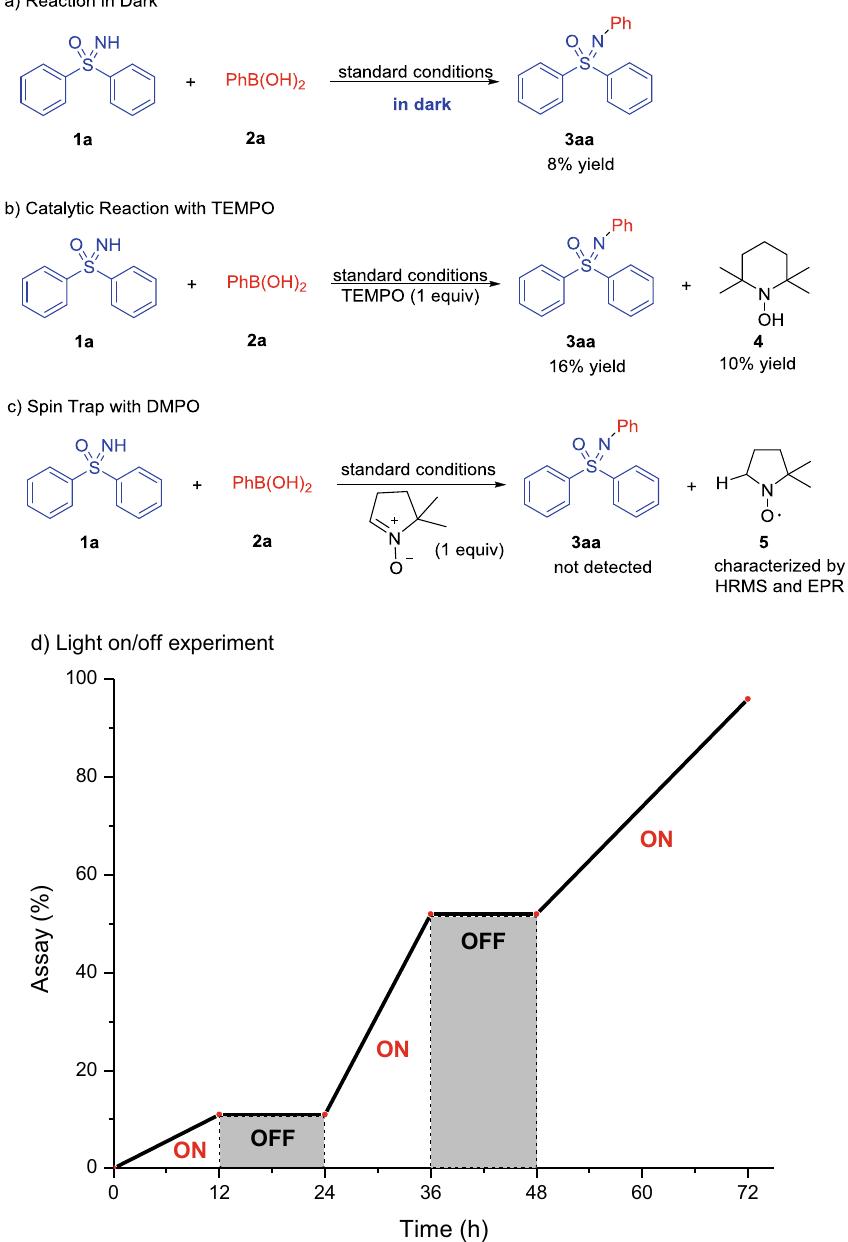
Fig. 2 Mechanistic probes. a Examination of the role of ambient light. b Probing the radical pathway of copper-catalyzed Chan-Lam coupling. c Spin trapping experiments. d Light on/off experiment with copper-catalyzed Chan-Lam coupling reaction of 1a and 2a